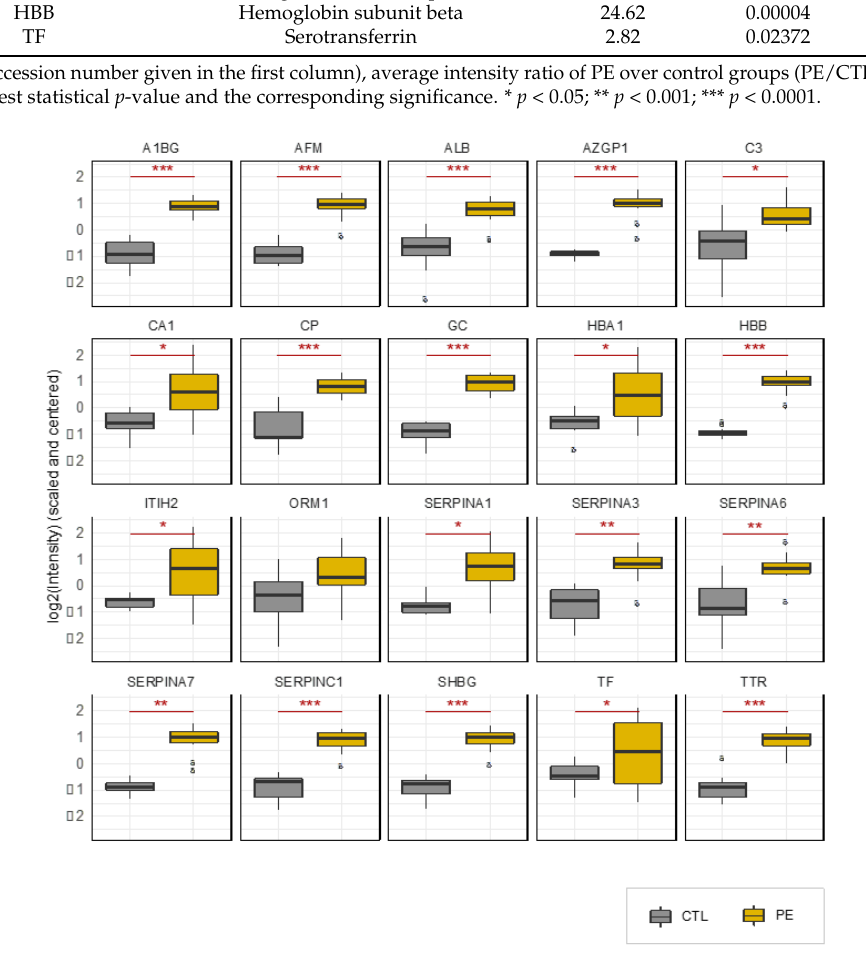
Figure 4. Validation study: Distribution of intensities measured by targeted proteomics of 21 urinary proteins in women with and without preeclampsia. The boxplots represent the distribution of intensities in each group (grey: control, yellow: PE) as well as the median (line), the interquartile (box) and the maximum and minimum values within 1.5 times the interquartile range (whisker) of 21 proteins monitored by targeted proteomics in urine samples of women with preeclampsia or women with uncomplicated pregnancies. Statistical significance is displayed above each graph: * p < 0.05; ** p < 0.01; *** p < 0.001.